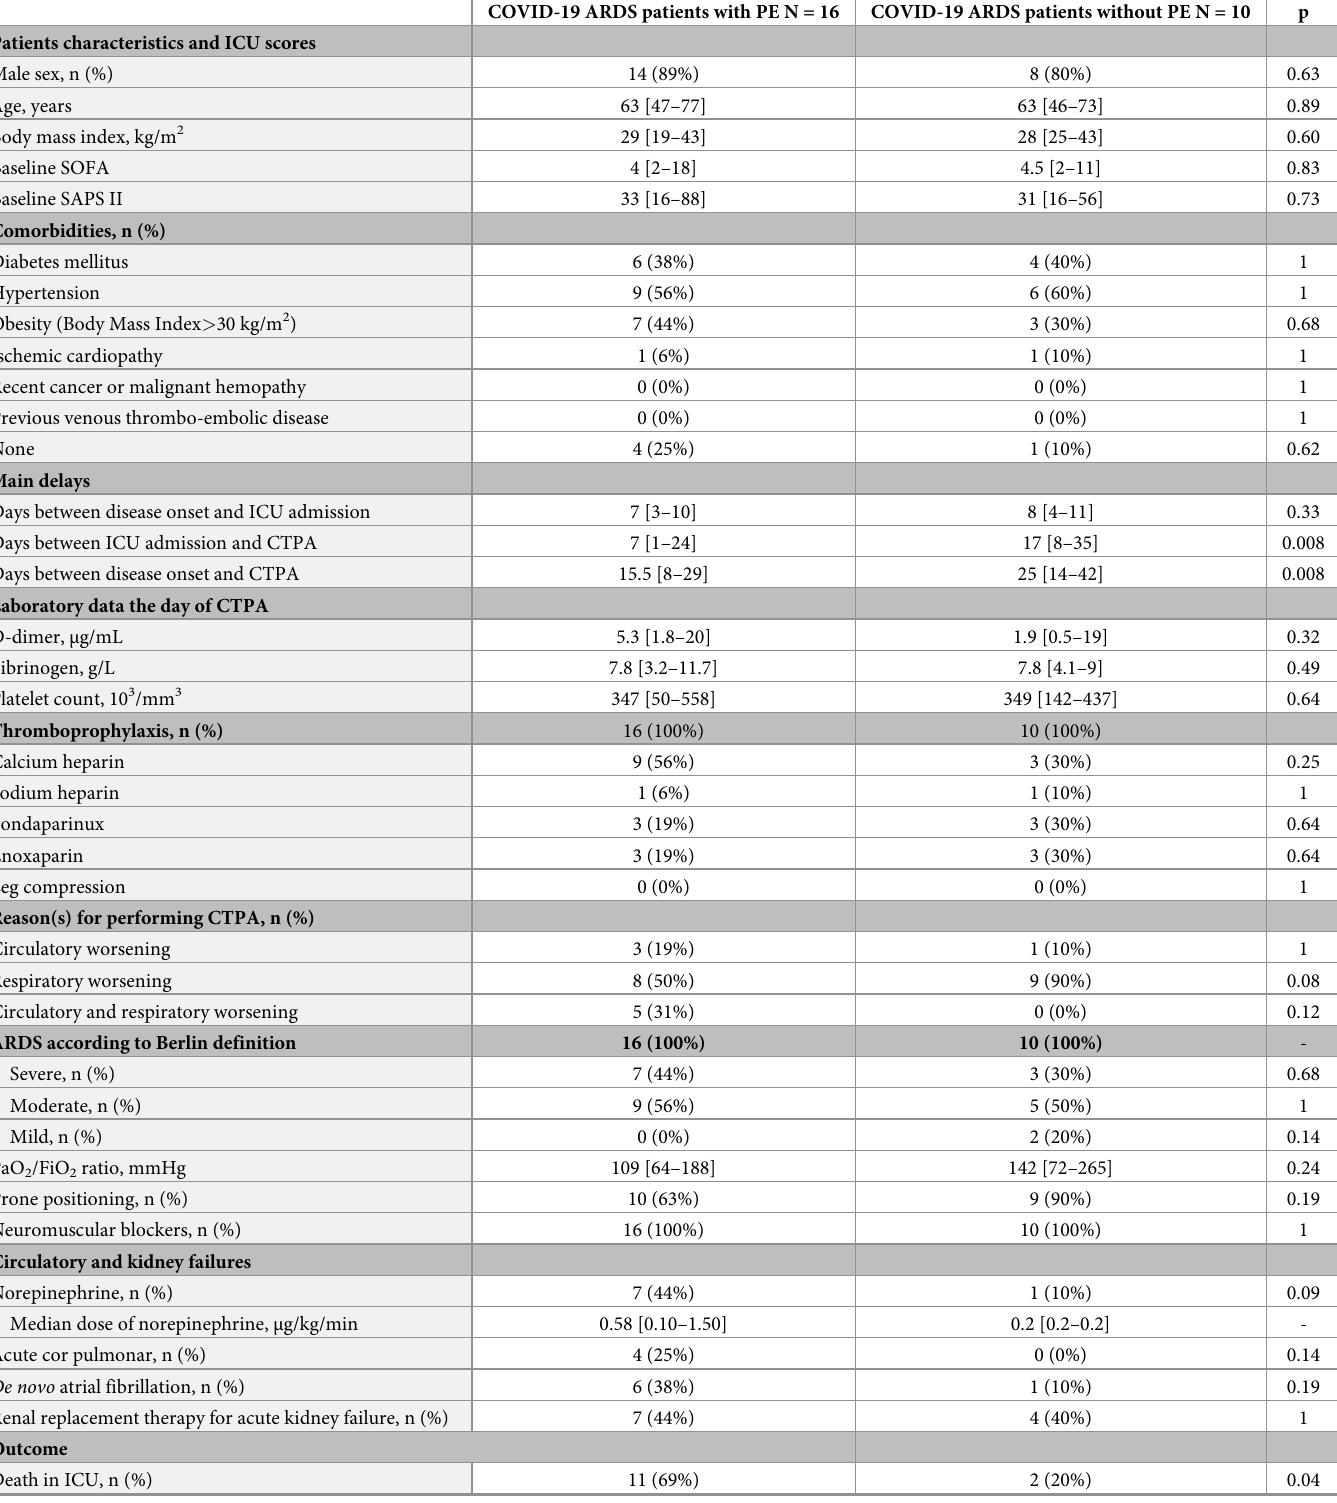
Table 2. Comparison of ARDS COVID-19 patients with (n = 16) or without (n = 10) pulmonary